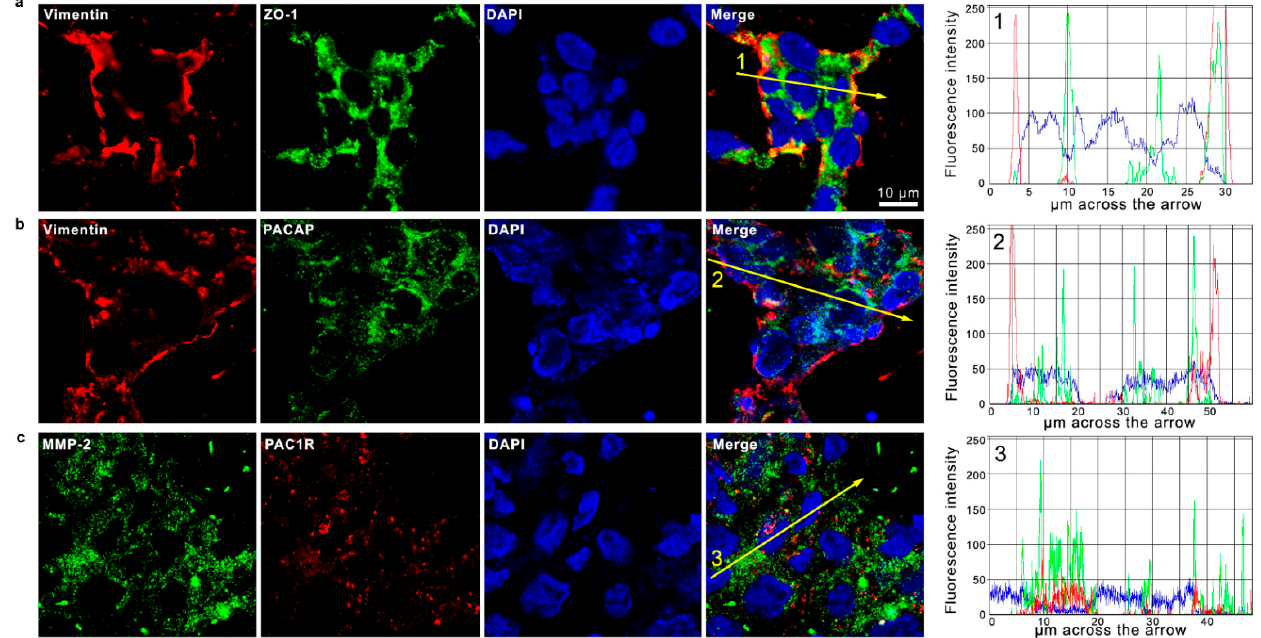
Figure 5. Co-expression of PACAP and PAC1R with EMT-related markers in human GBM sections. Representative photomicrographs showing the cellular co-localization of Vimentin (red) with ZO-1 (green) ( a ); Vimentin (red) with PACAP (green) ( b ); and MMP-2 (green) with PAC1R (red) ( c ). Nuclei were stained with DAPI (blue). Photomicrographs are representative results of fields taken randomly from each slide and scanned by confocal laser scanning microscopy (CLSM; Zeiss LSM700). The graphs indicate the measured fluorescence intensity of the single channels across the arrow, allowing us to visualize the specific peaks of single the proteins or their co-expression detected by overlapped signals. Fluorescence intensity graphs were obtained with ZEN-20210 software.